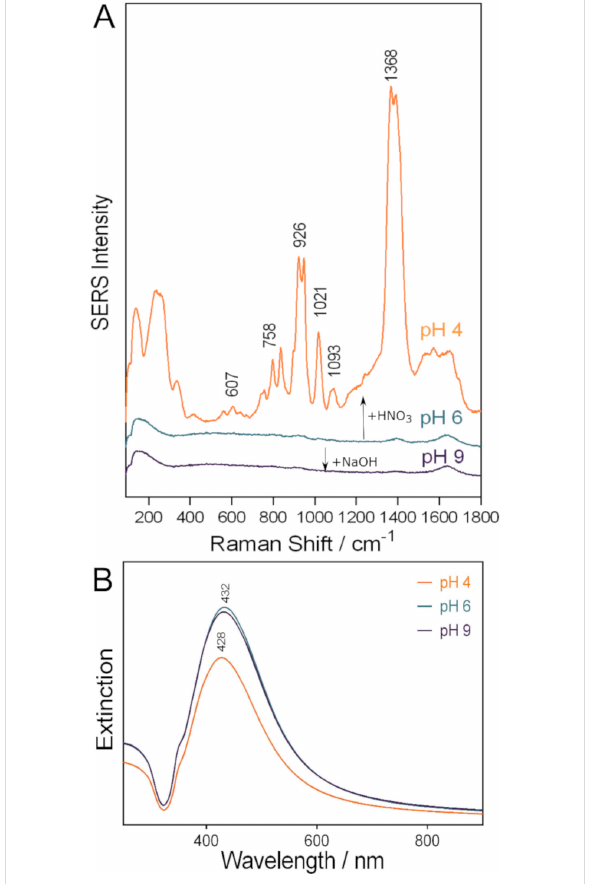
Figure 1: (A) SERS spectra and (B) UV–vis extinction spectra of the colloidal solution of cit-AgNPs at pH values between 4 and 9 as indi- cated in the